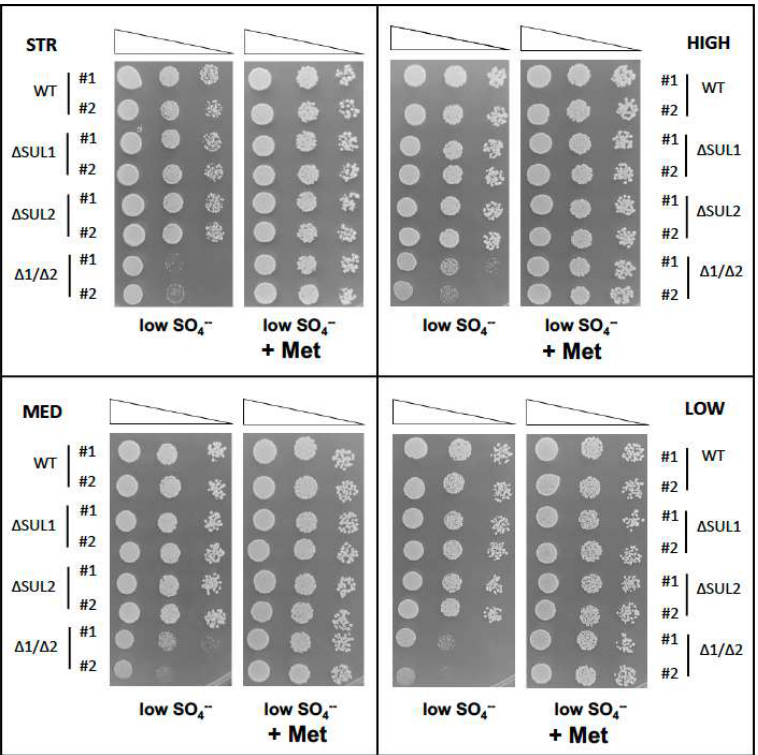
Figure 2. Sulphate and methionine requirements of winery yeast strains deleted for SUL1 and/or SUL2 genes. As in Figure 1, S. cerevisiae cells of the indicated strains (STR, HIGH, MED, and LOW) were spotted on SD containing low SO 4-- concentration, either without aminoacids (panels on left) or supplemented with methionine (panels on right), and incubated at 28 °C for 3 days. Two clones (#1 and #2) for each strain were compared, carrying either parental alleles (WT), deleted for SUL1 ( ΔSUL1 ), SUL2 ( ΔSUL2 ), or both genes ( Δ1/Δ2 ). Images are representative of three independent experiments.